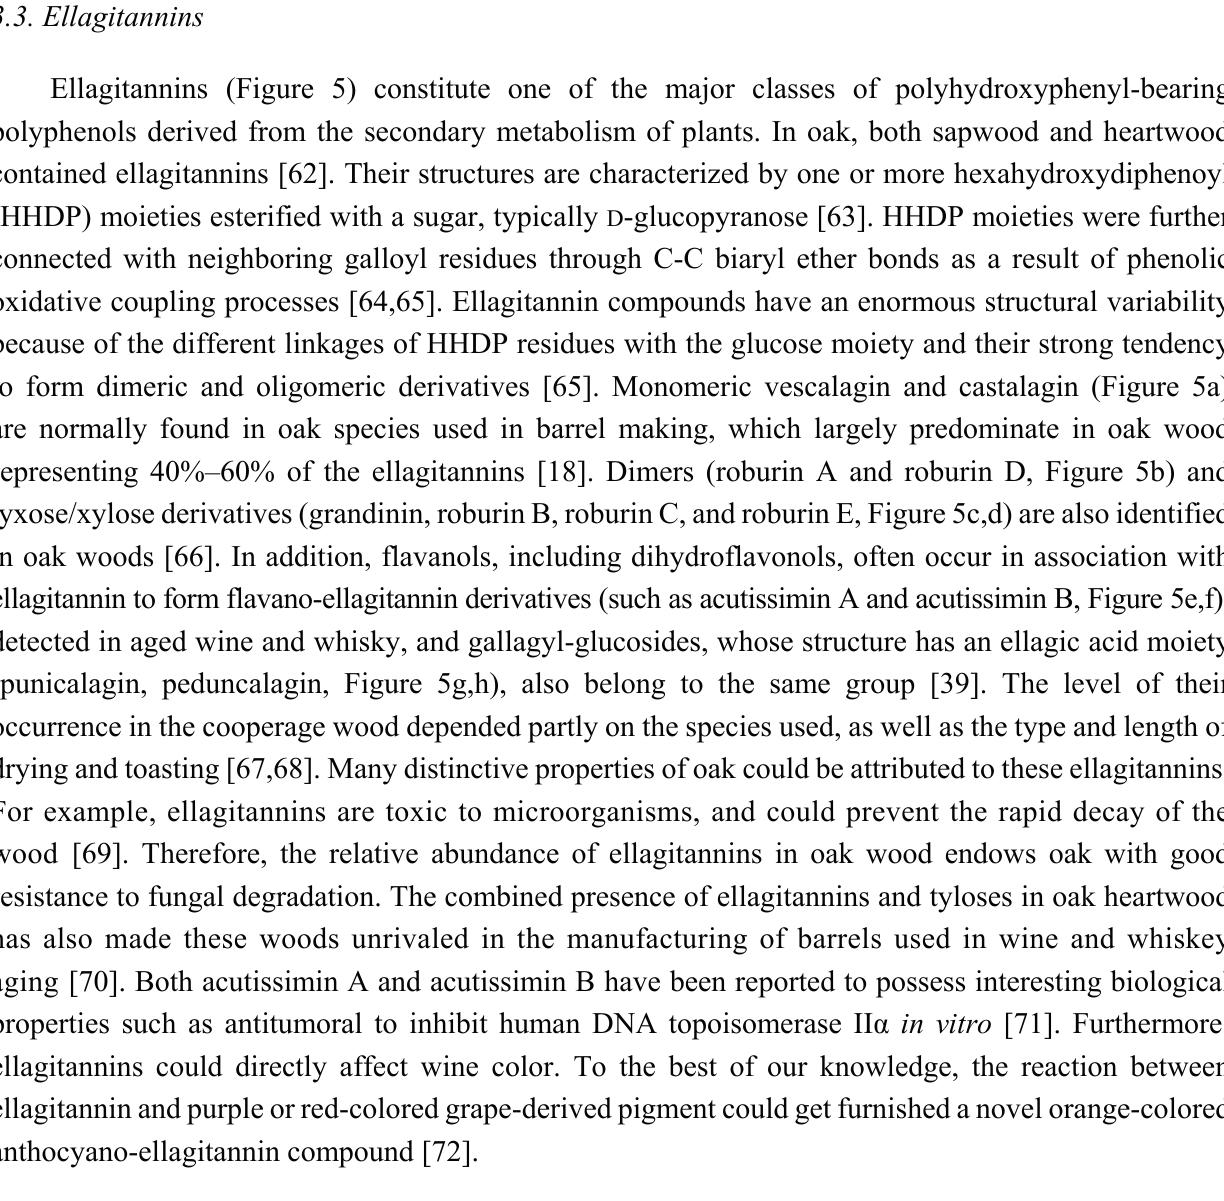
Table 4. The compigmentation effects of cyanidin-3- O -glucoside (Cy-3-glu) and cyanidin-3- O -sophoroside (Cy-3-soph) with four hydroxycinnamic acids [61]. Hyperchromic Effect (%) Bathochromic Shift ( ∆ λ max , nm) Anthocyanins pH Coumaric Caffeic Ferulic Sinapic Coumaric Caffeic Ferulic Sinapic Acid Acid Acid Acid Acid Acid Acid Acid 3.2 11.6 18.8 25.3 29.7 2.5 4.5 6.6 8.7 Cy-3-glu 4.0 27.7 41.0 63.9 110.5 2.2 4.0 6.8 10.2 3.2 9.9 11.2 16.5 23.9 2.5 3.8 5.2 5.5 Cy-3-soph 4.0 16.3 22.7 40.7 60.9 2.3 2.6 6.5